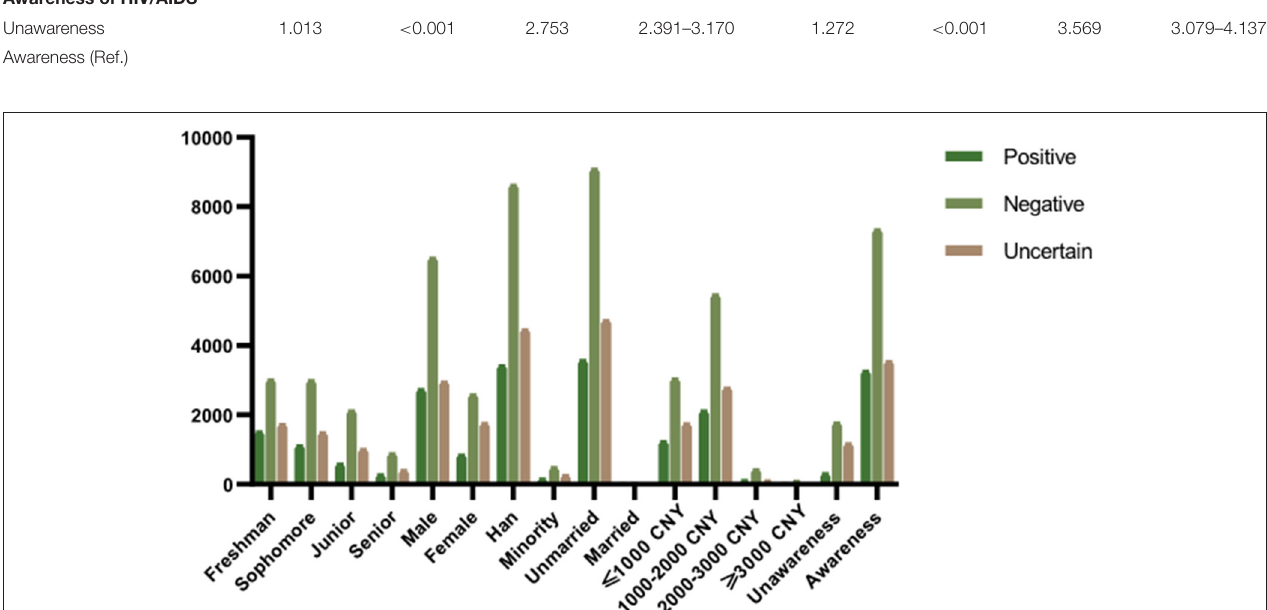
FIGURE 5 | Attitudes towards live with HIV-positive